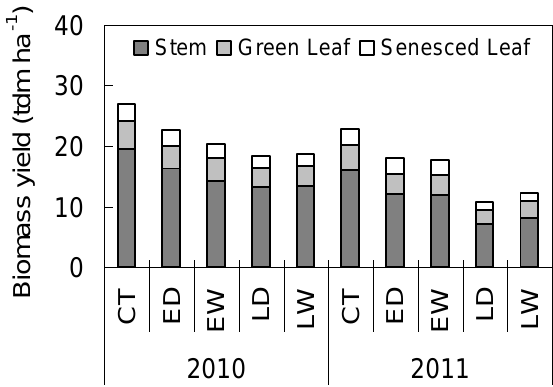
Figure 3. Stem, green leaf and senesced leaf trafficked zone biomass dry matter yield (tdm ha − 1 ) in November 2010 and 2011. CT = control, ED = early-dry, EW = early-wet, LD = late-dry and LW = late-wet.